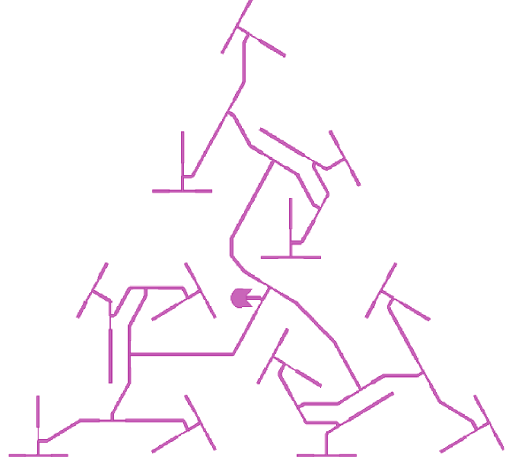
Figure 12: Receive BFN layout.